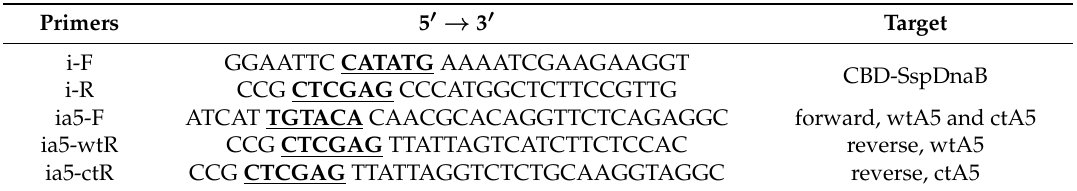
Table 4. Primers for intein fusion